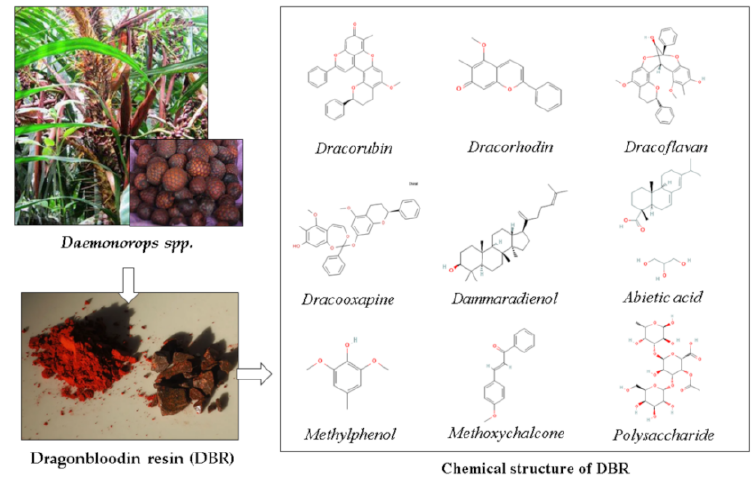
Figure 1. Chemical component of DBR (adapted from